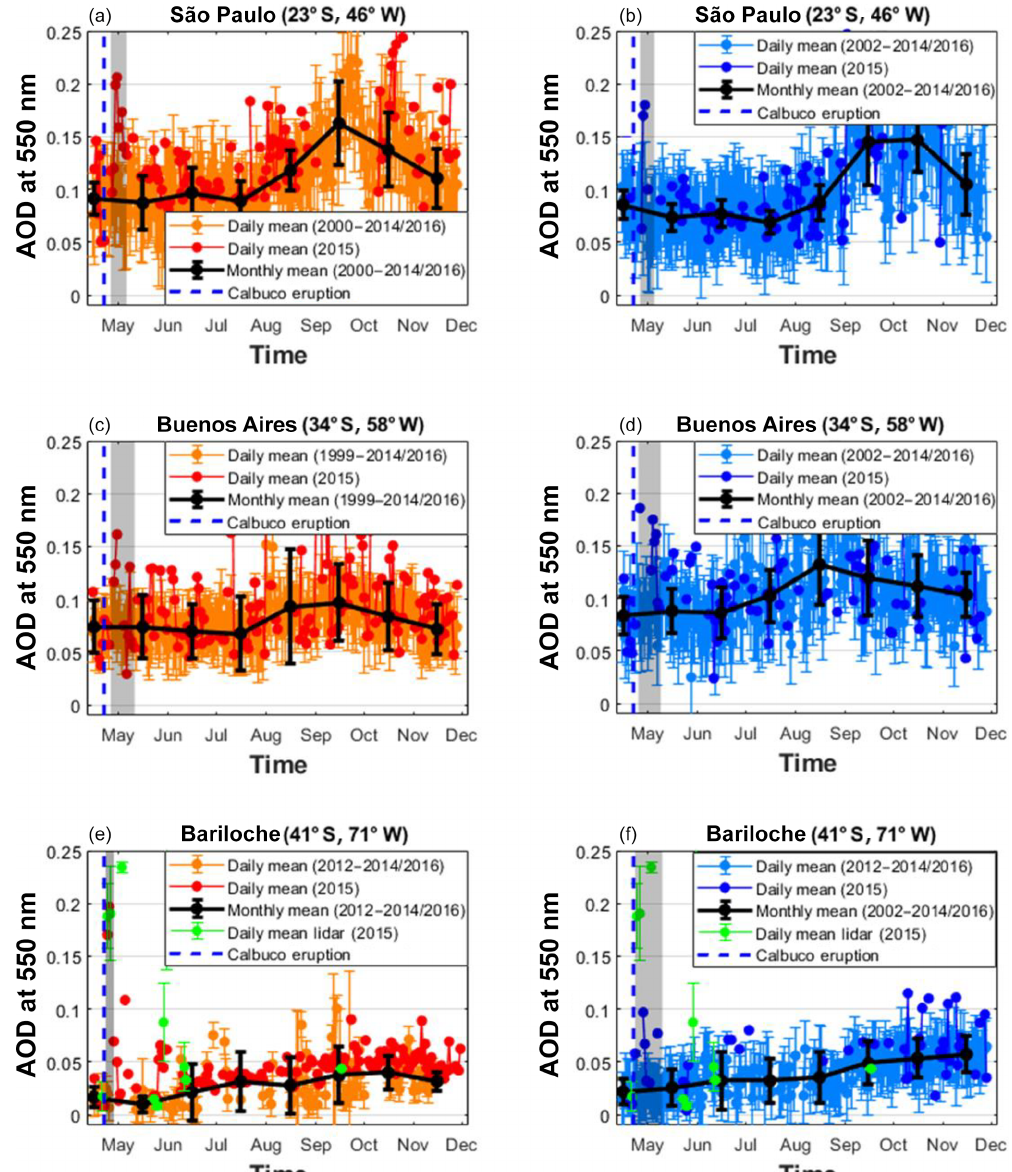
Figure 4. Daily mean AOD values (550nm) obtained over (a, b) São Paulo, (c, d) Buenos Aires, and (e, f) Bariloche from sun photometer and lidar observations (a, c, e) as well as MODIS observations (b, d, f) from 15 April to 1 December. The grey area corresponds to the influence of the volcanic plume over a given site. The black line indicates the monthly mean